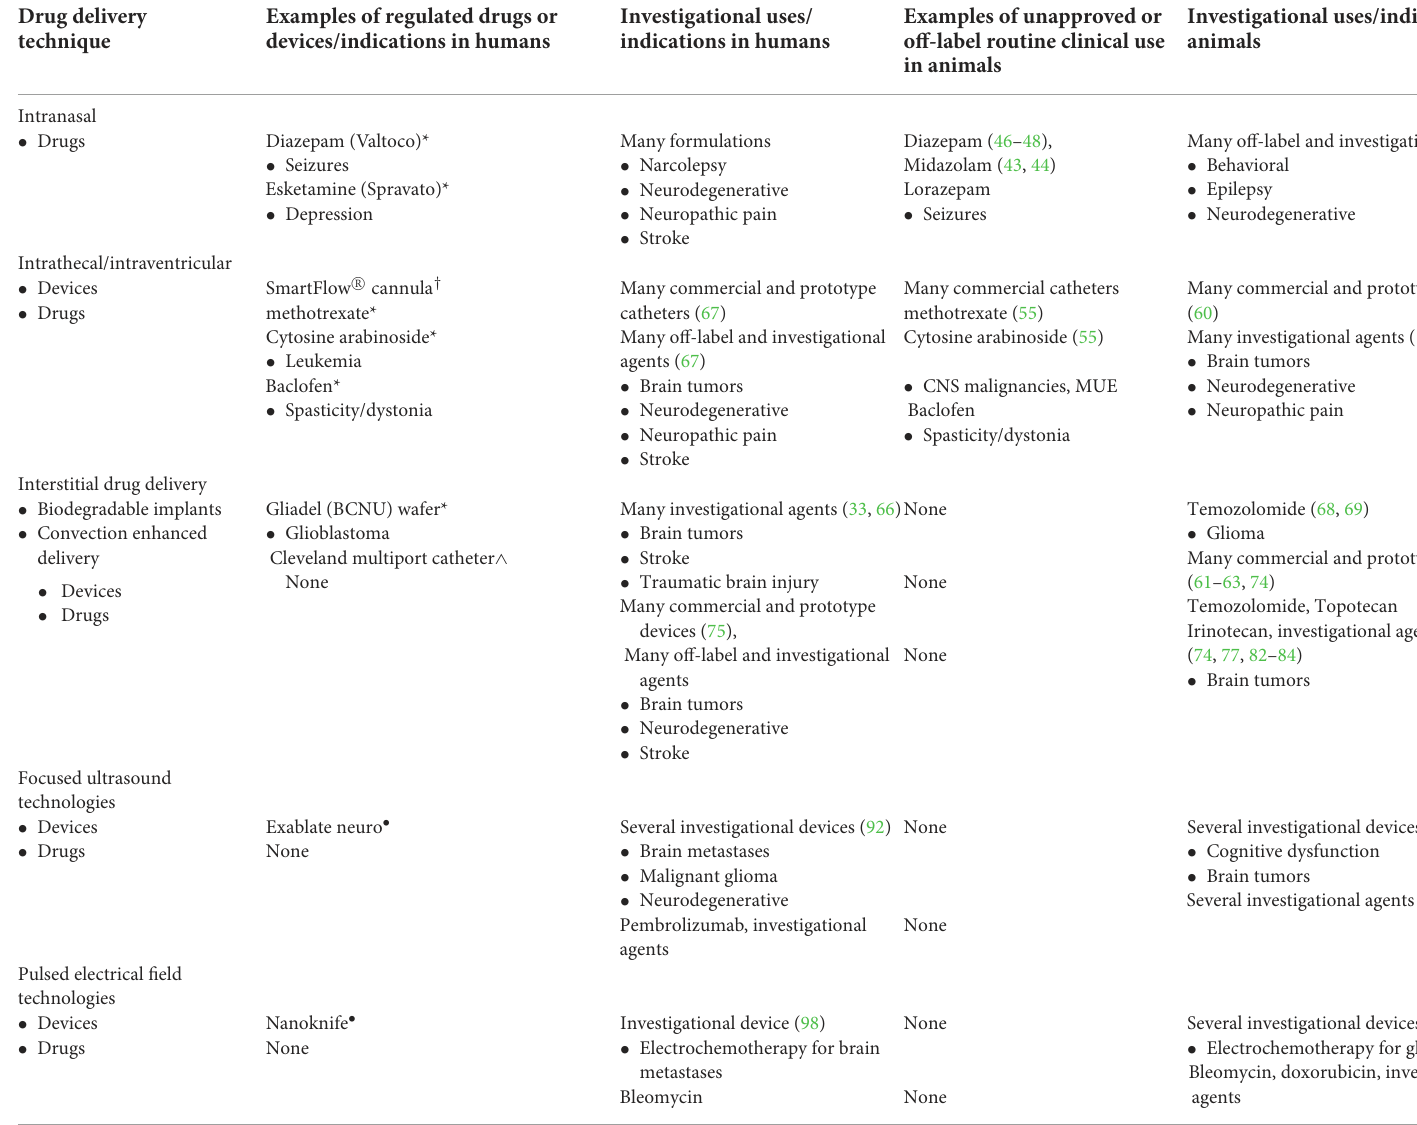
TABLE 2 Current, comparative regulatory landscape of cns drug delivery techniques and agents for neurological